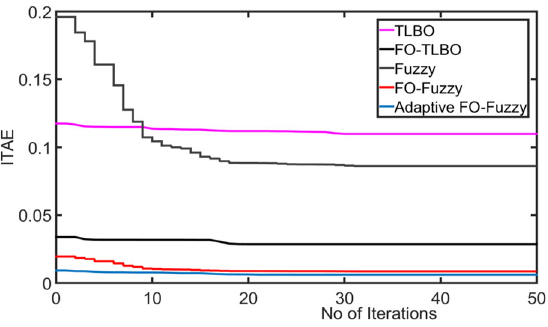
Fig. 12 Optimized parameters of various controllers in